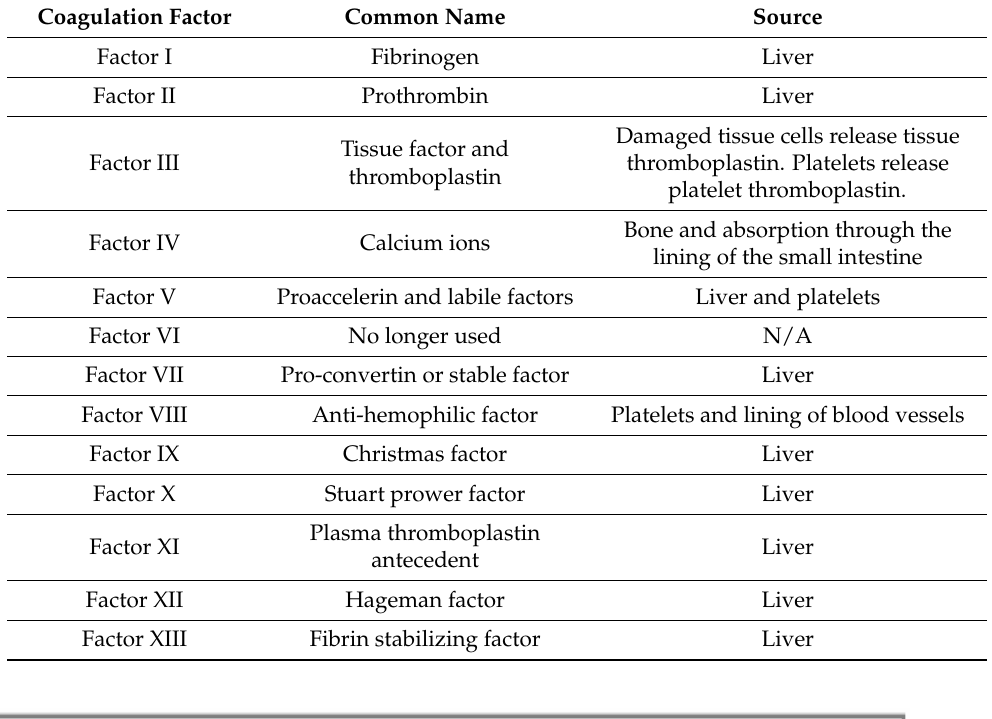
Table 1. Several coagulation factors and their respective sources.